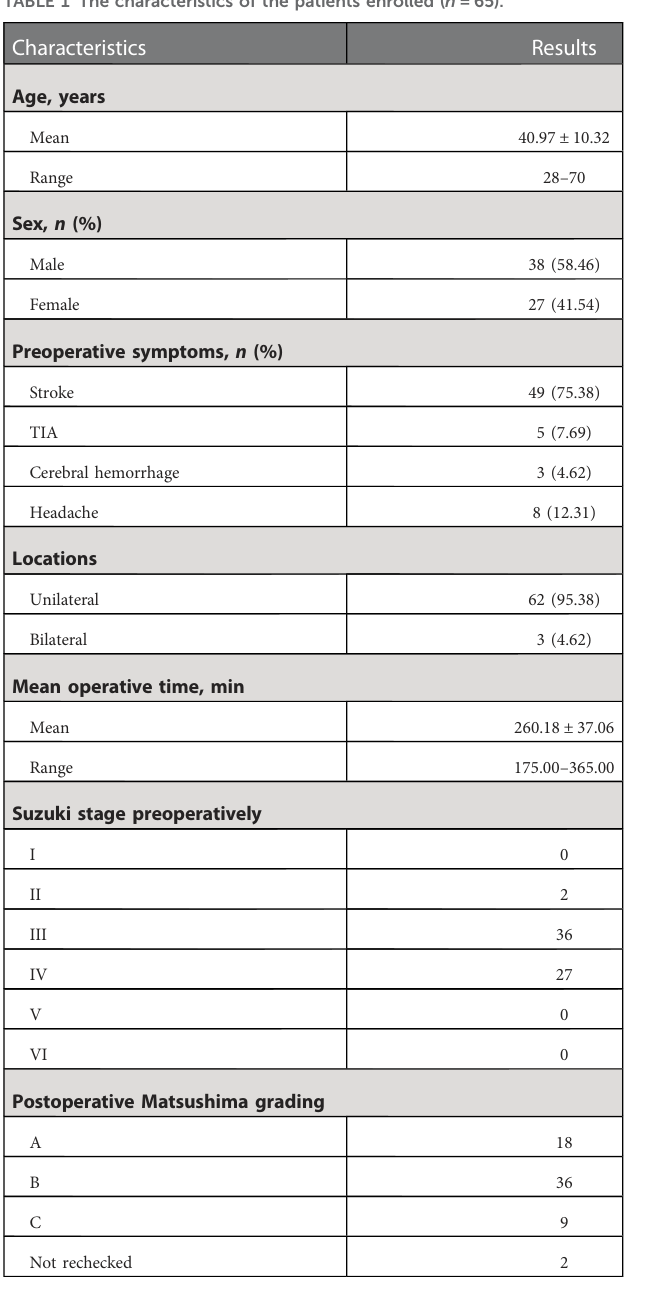
TABLE 1 The characteristics of the patients enrolled ( n =65).